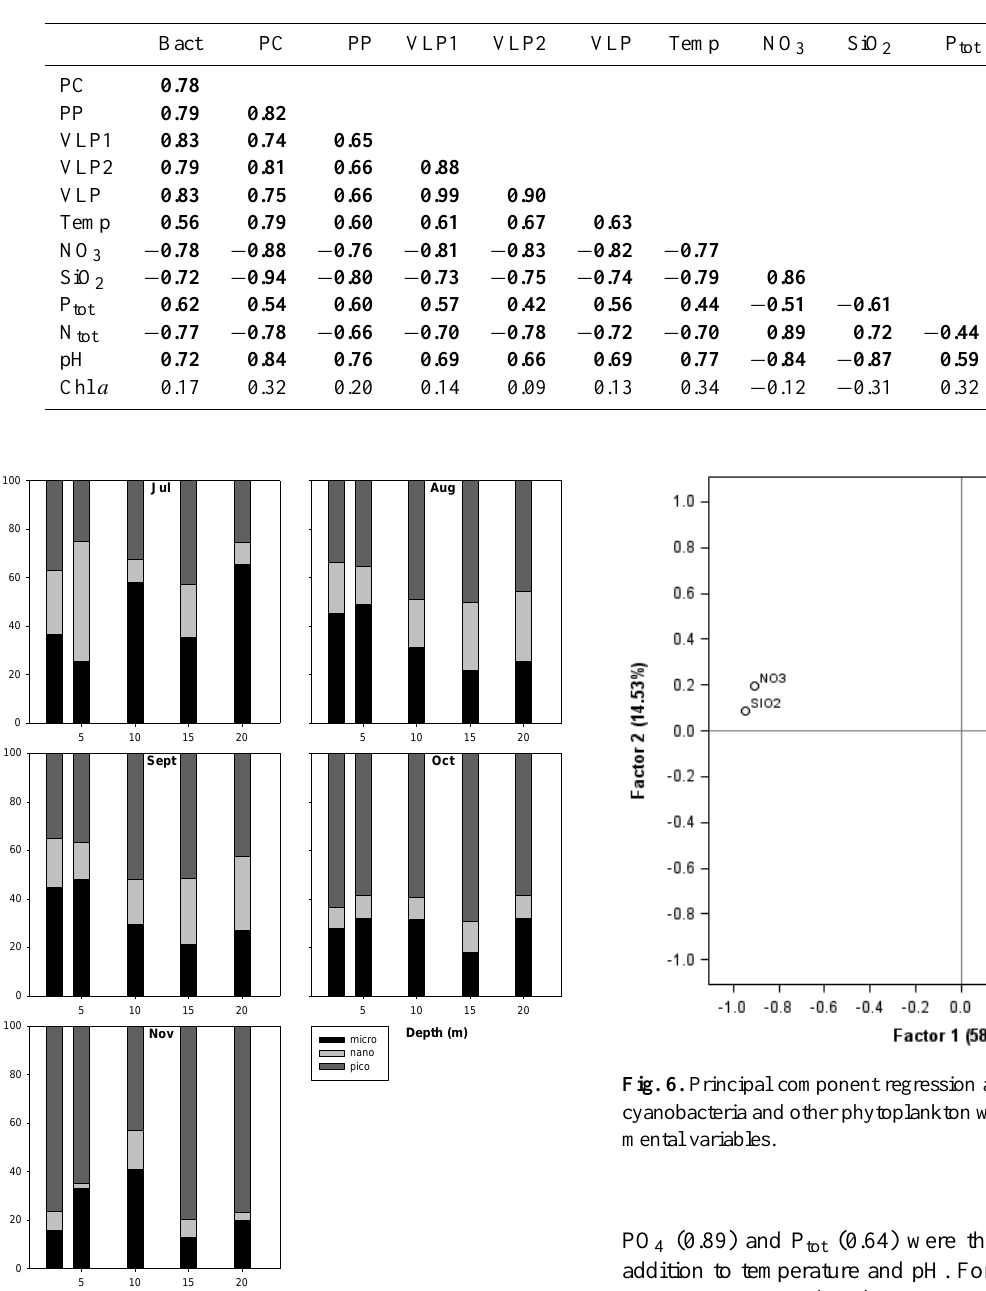
Table 3. Results of Pearson’s correlation analysis to test for empirical correspondence among estimated variables. Abbreviations are ex- plained in the main text. Significant correlations are in bold at P < 0.01 at n =42.